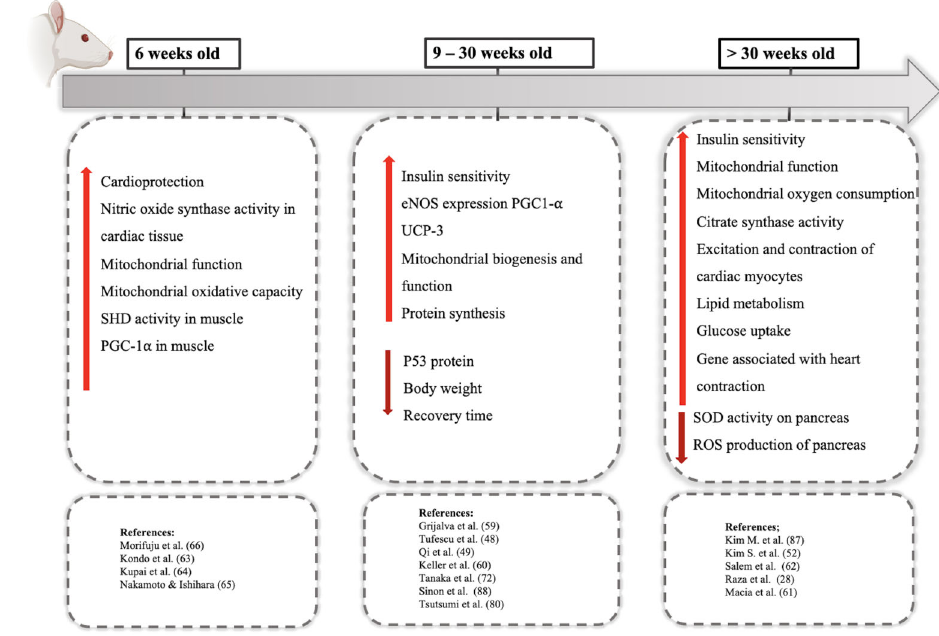
Figure 4. Summary of the physical exercise effects in Goto-Kakizaki (GK) rats of different